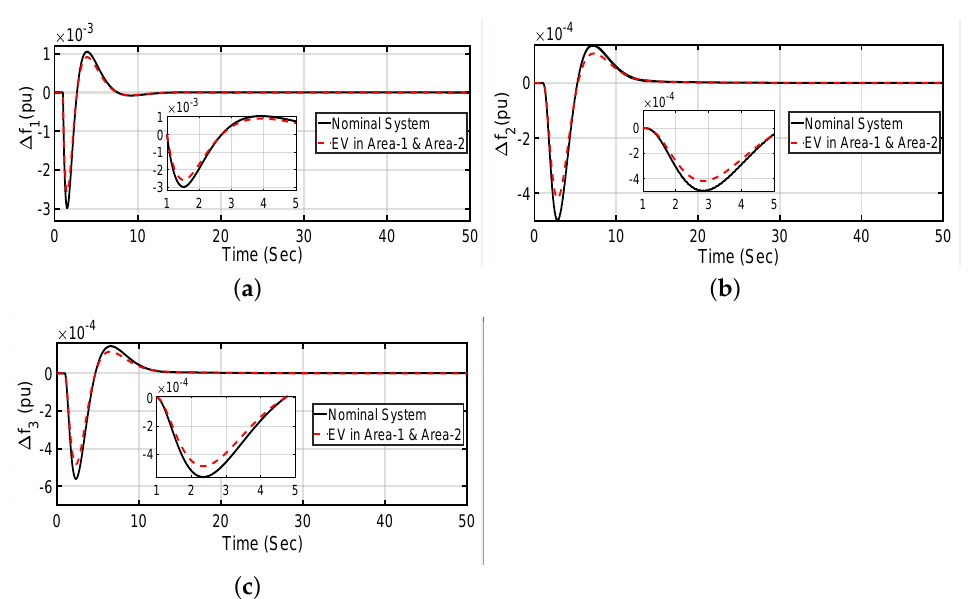
Figure 11. Response comparison when EVs are connected in Area 1 and Area 2 only. ( a ) ∆ f 1 ; ( b ) ∆ f 2 ; ( c ) ∆ f 3 .